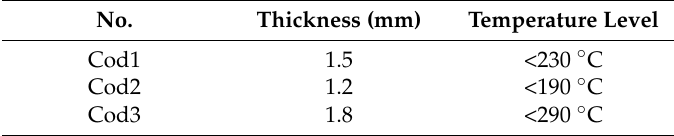
Table 4. Thickness of the conducting heat plate for optimization.